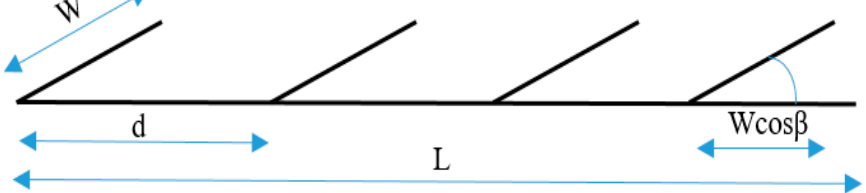
Figure 14. PV tiled system layout option-based free-standing from shading